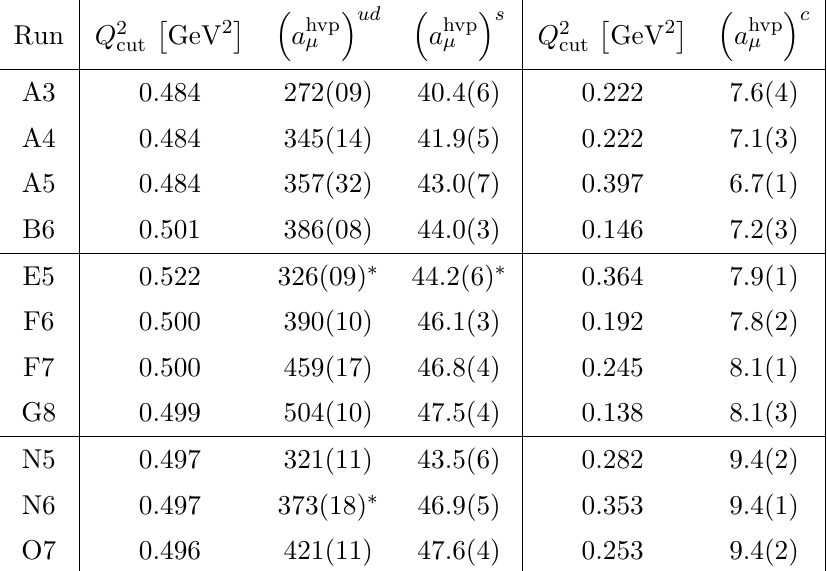
determined for Q 2 0 : 5 GeV 2 are listed in the fourth column of table 3. For cut (cid:25)